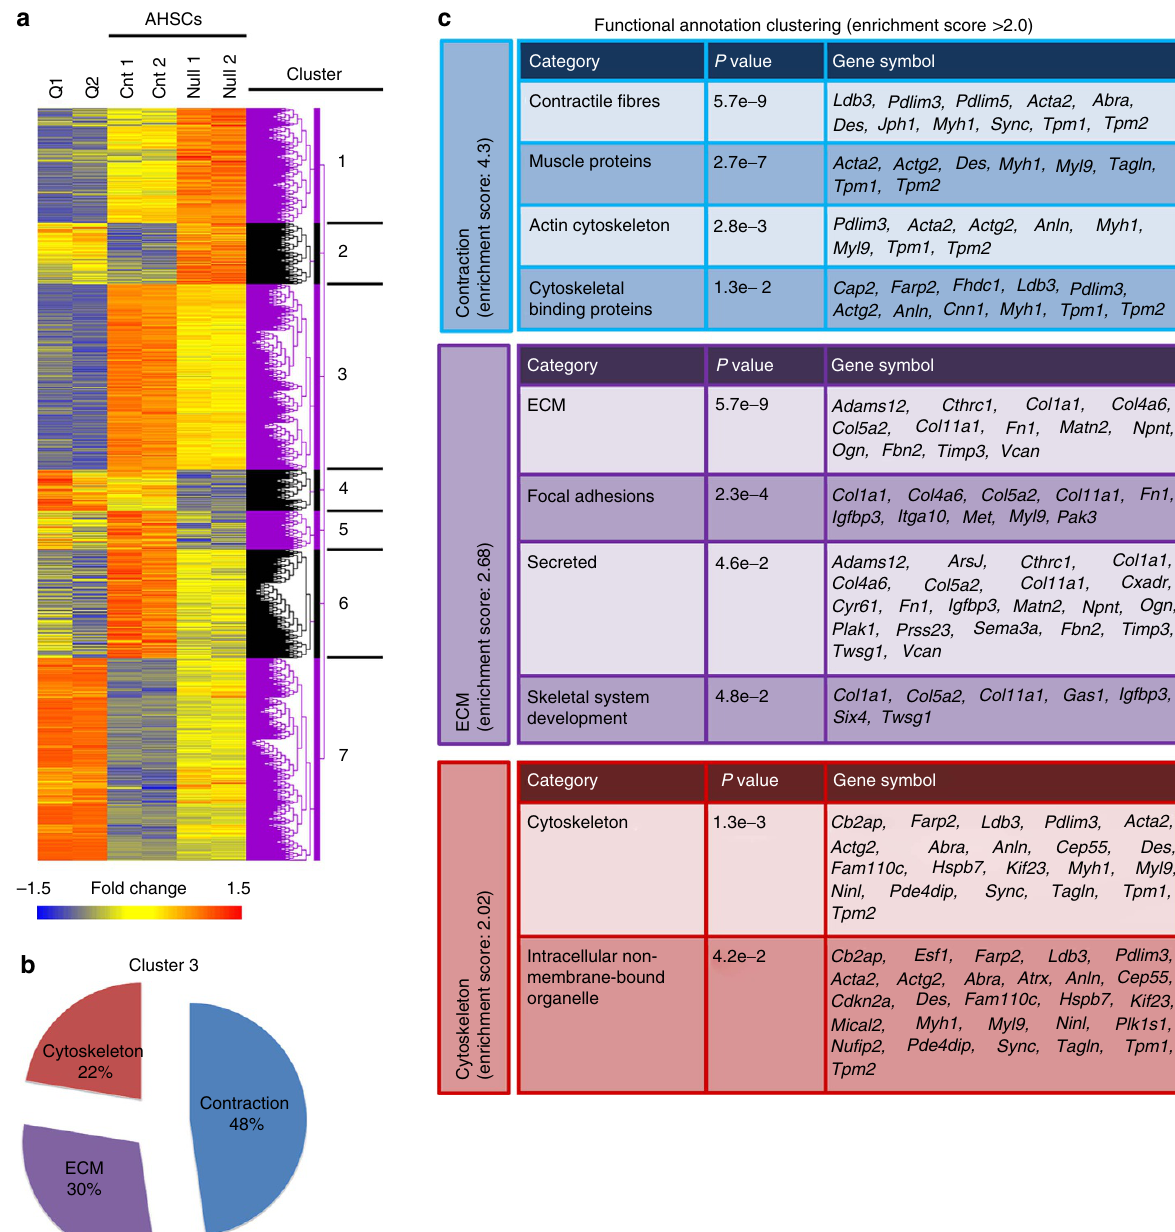
Figure 2 | Integrin beta-1 is required for multiple pro-fibrotic features in activated HSCs. ( a ) Heatmap and cluster analysis showing gene expression changes (1.5-fold; P o 0.05) in biological duplicates of activated (A) control (‘Cnt’) HSCs and following integrin beta-1 inactivation (‘Null’). Quiescent (Q) HSCs are also included for comparison. Seven clusters were identified based on upregulated (red), downregulated (blue) and intermediate (yellow) gene expression. ( b , c ) Functional annotation by gene ontology for enrichment in Cluster 3. Proportions are shown in b . Individual categories and the genes underlying them are shown in c .